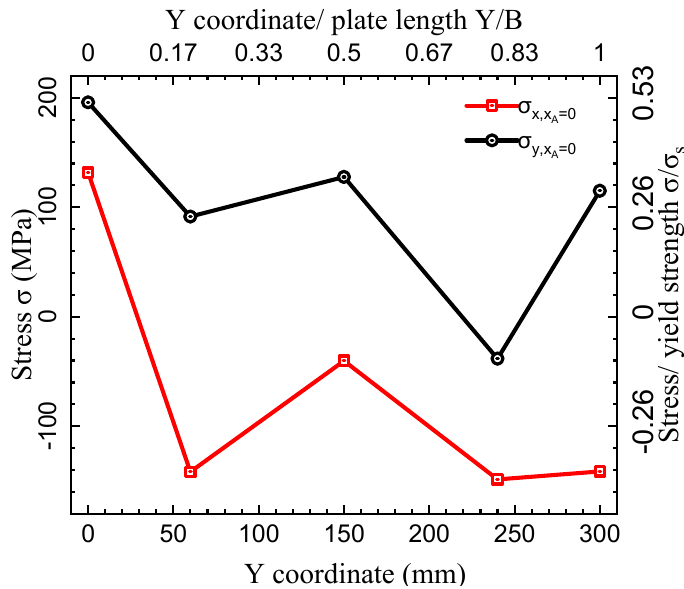
Figure 27. The stress on path L yA = 0 . It can be seen from Figure 28 that path L yA = 25 is located in the heat-affected zone of welding on surface A, the maximum tensile residual stress in the Y direction in the heat-affected zone can reach 361.43 MPa, and the average stress is 185.94 MPa,